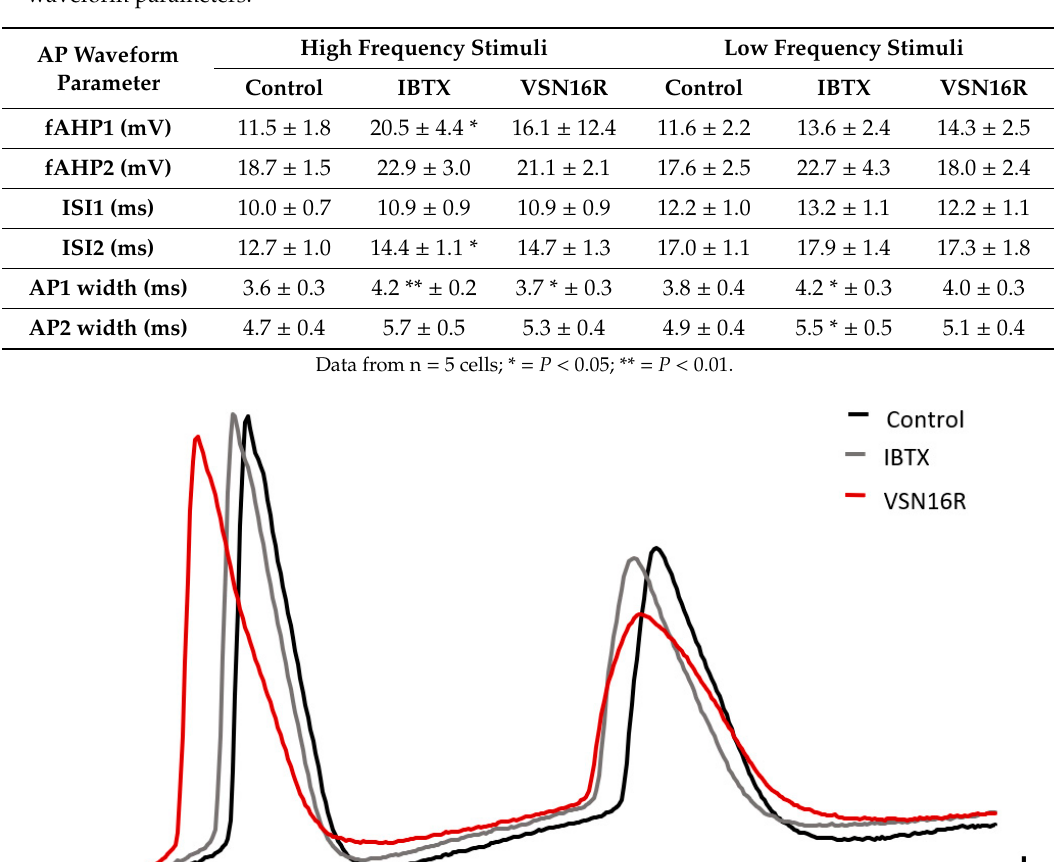
E ff ects of iberiotoxin (IBTX) and subsequent application of VSN16R on AP waveform